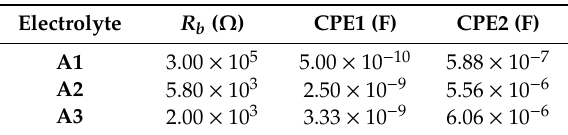
Figure 3. Cole–Cole plot for ( A1 ), ( A2 ) and ( A3 ) electrolytes. Table 2. The parameter of circuit element for the electrolyte system with different glycerol concentration at room temperature.